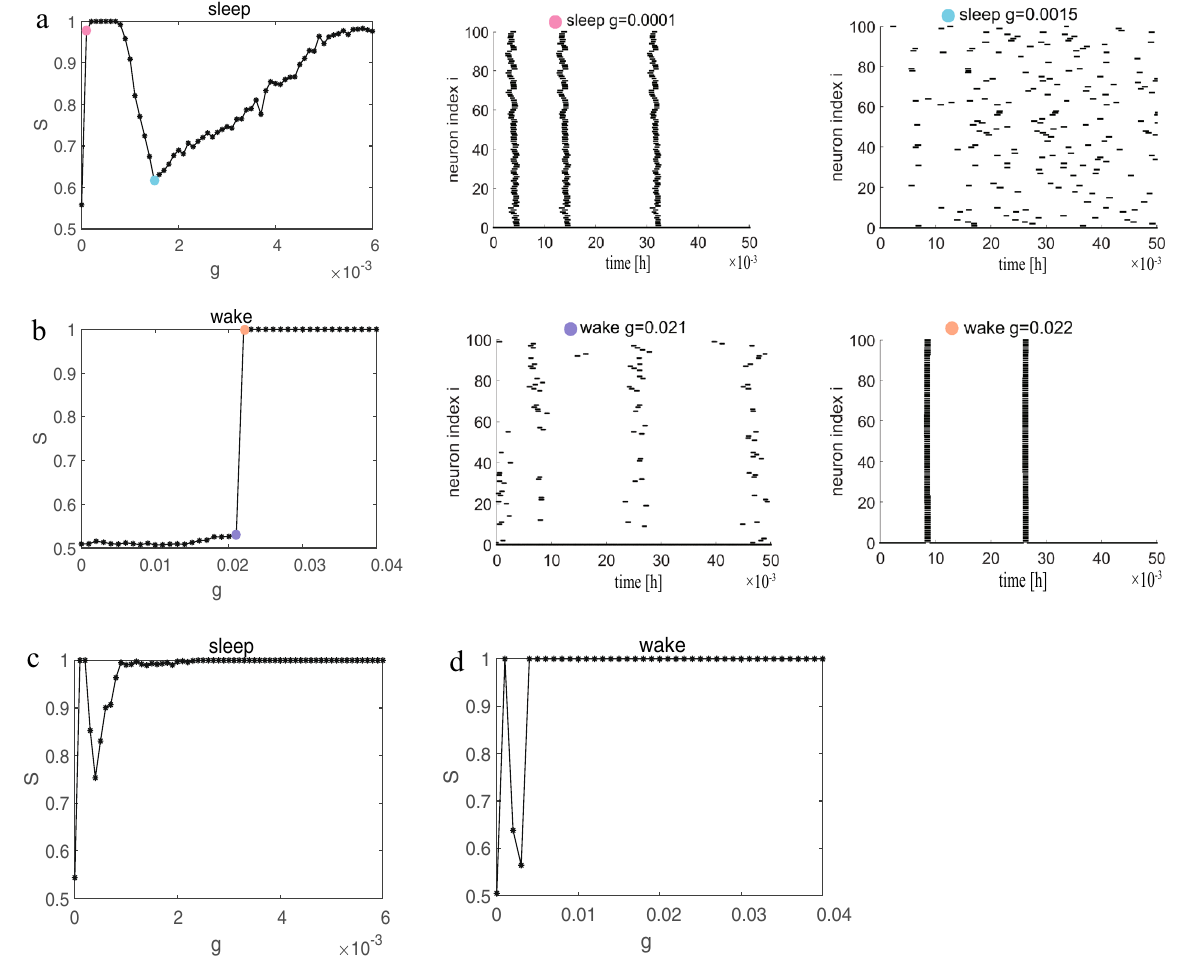
Figure 3. The lattice network with random long-range connections. ( a )–( b ) Each neuron randomly adds 1 long-range connection during sleep and wake. ( c )–( d ) Each neuron randomly adds 10 long-range connections during sleep and